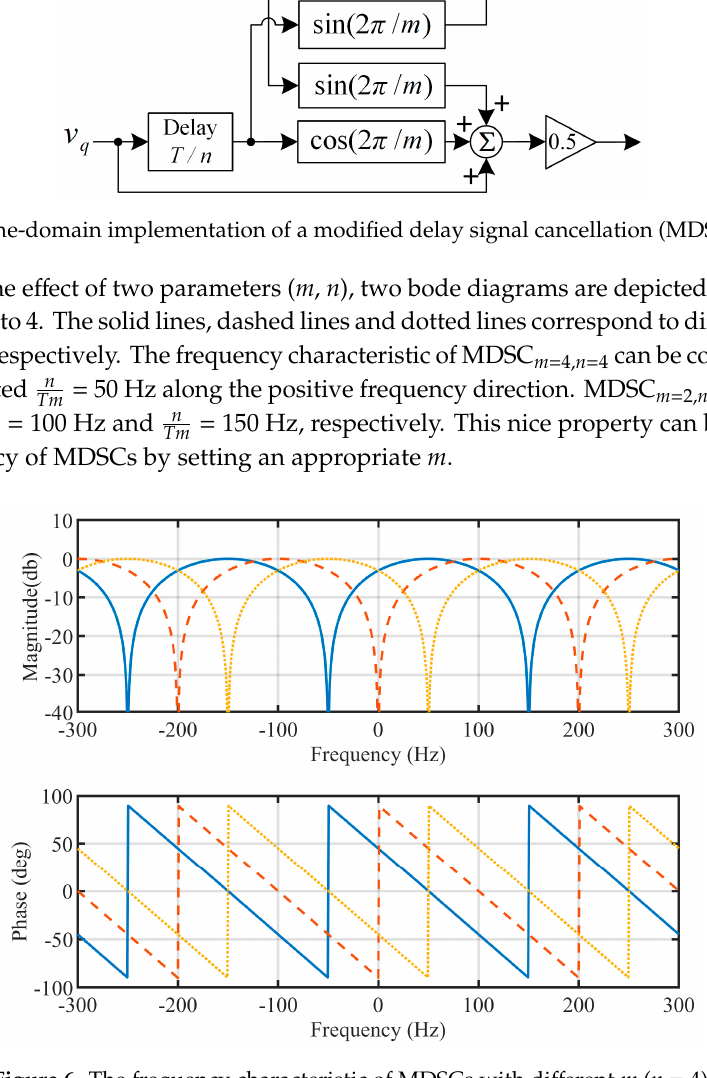
Figure 6. The frequency characteristic of MDSCs with different m ( n = 4).